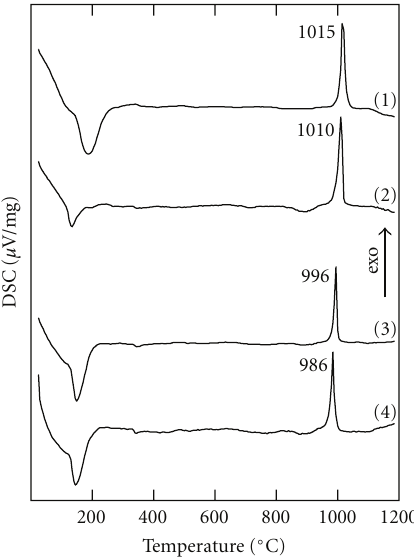
Figure 4: DTA curves for the samples 1, 2, 3, and 4.